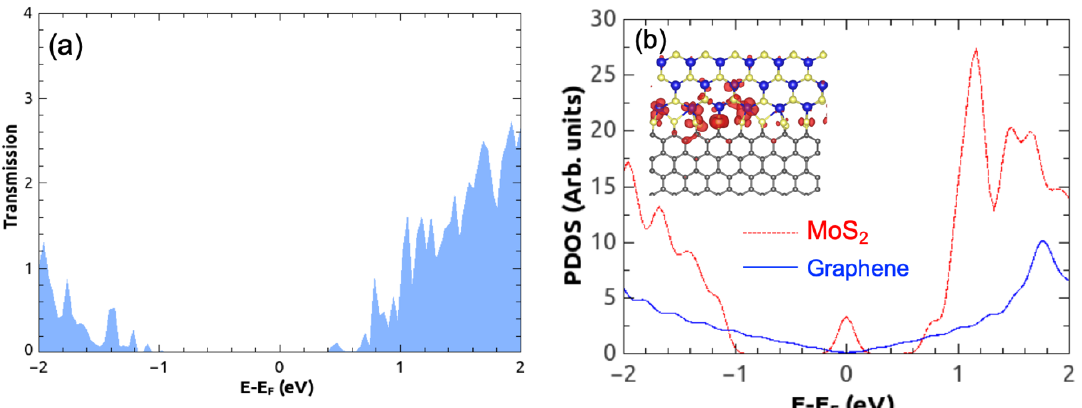
Figure 8 . ( a ) Computed transmission spectrum (at zero bias) of a graphene/MoS 2 lateral heterostructure with S-terminated zigzag edge contacts (model 4 in Figure 5). The Fermi level corresponds to the reference (zero) energy. ( b ) Partial electronic density of states (PDOS) of graphene and MoS 2 . The inset shows the isosurface charge density (0.01 e/Å 3 ) near the Fermi level. Adapted from Reference [59].